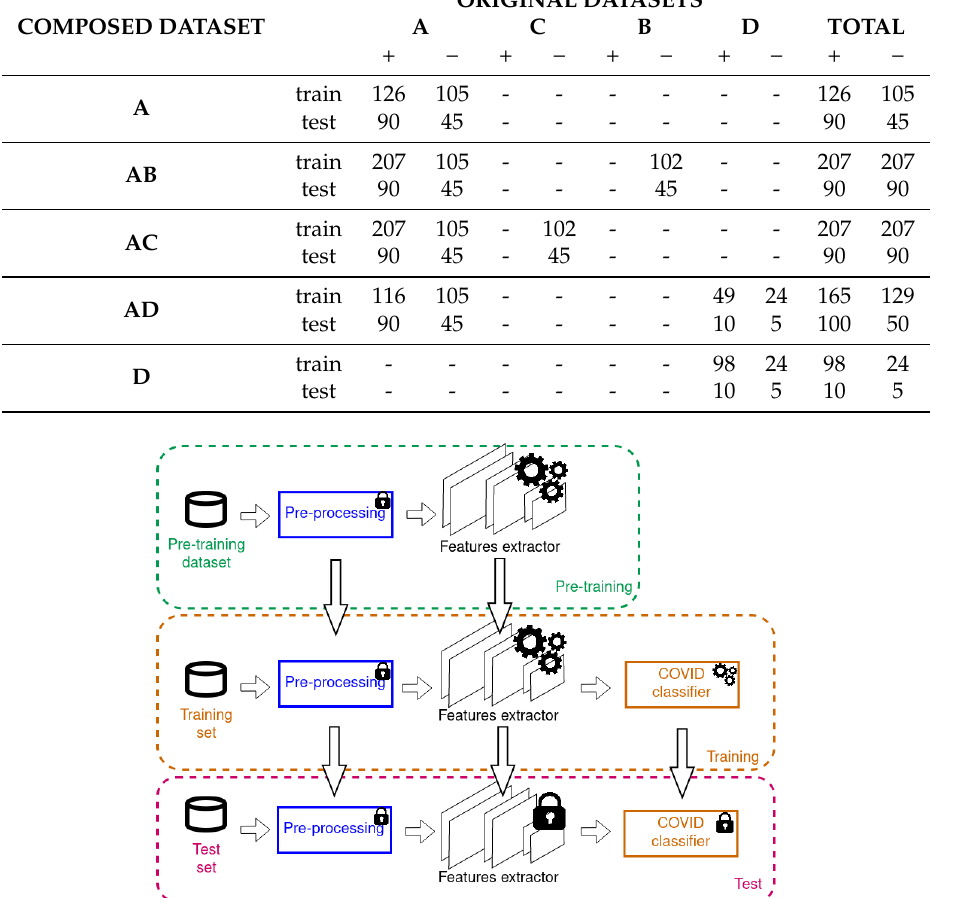
Figure 3. Summary of the training strategy. The feature extractor is (optionally) pre-trained on CXR pathology datasets and then fine-tuned on the COVID datasets. The presence of gears involves training/fine-tuning for the specific part, while the lock implies that part is not